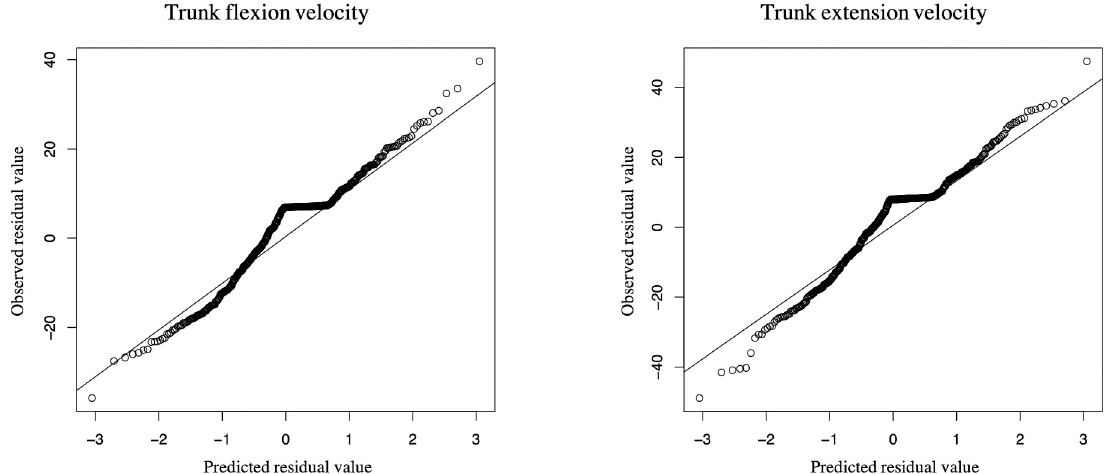
Fig 4. Residual plots of the GLMM. The Plot of each parameter approaches a 45˚ angle with residuals normally distributed, indicating that the quality of the GLMM is ensured.